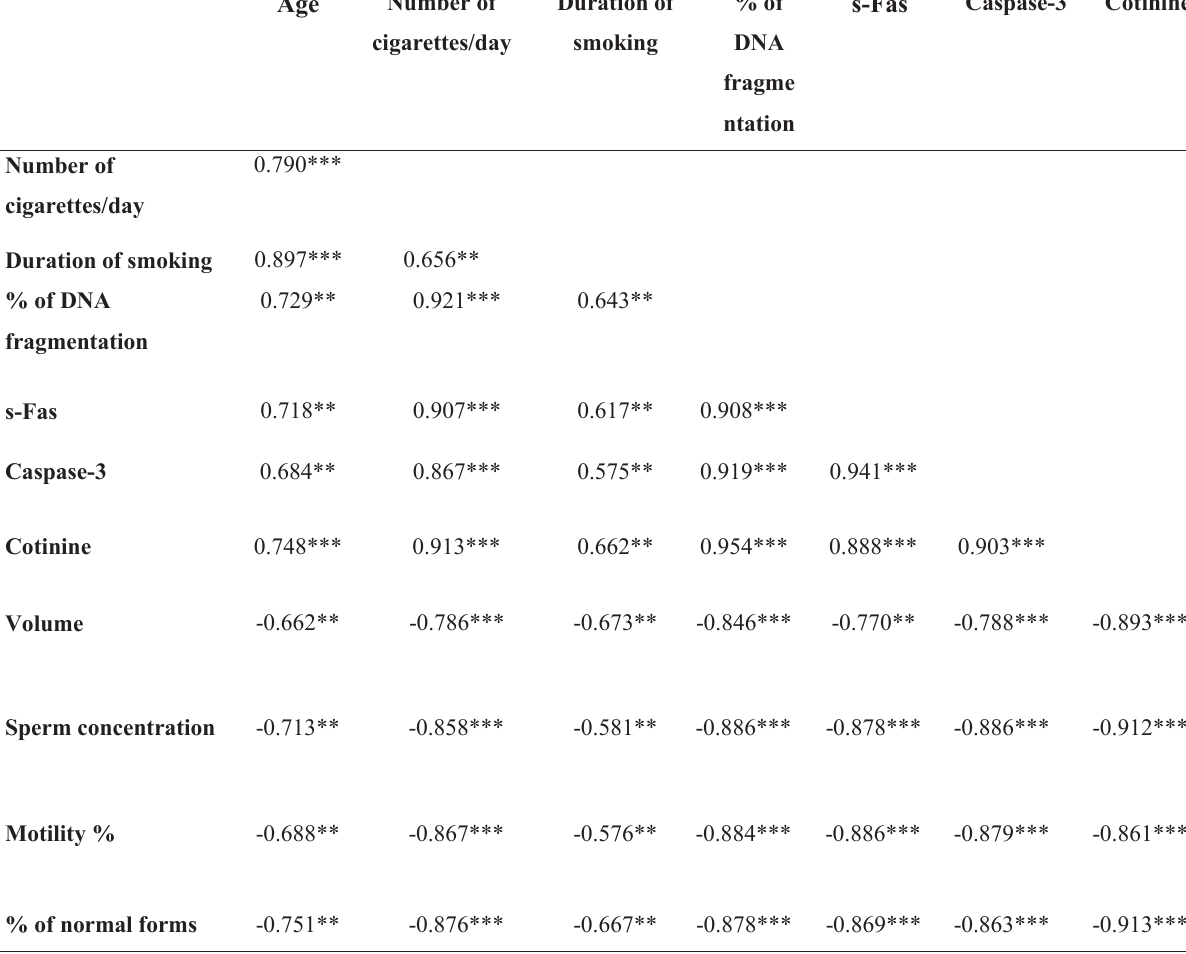
Pearson’s correlation was used.